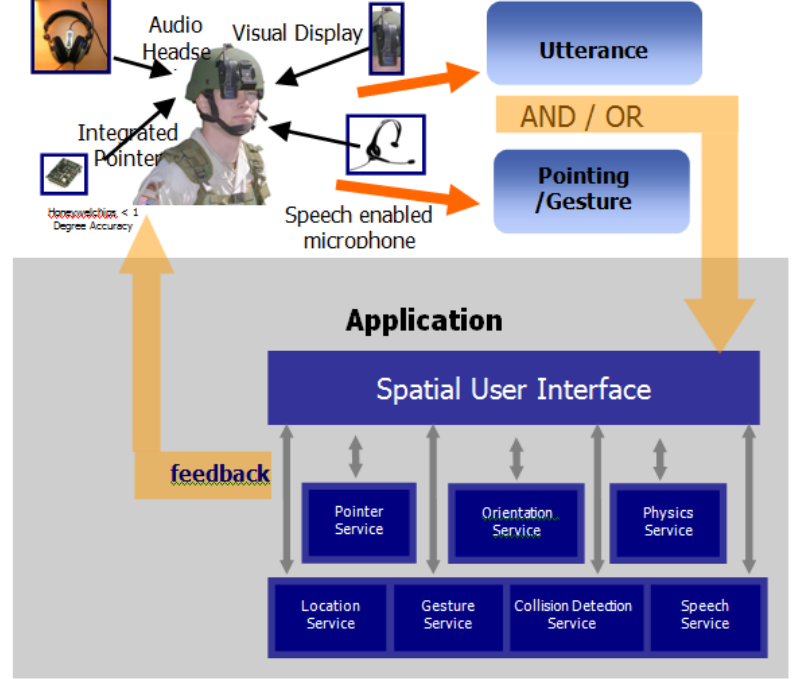
Figure 2. Interaction diagram describing how the interface works and the underlying agent-based